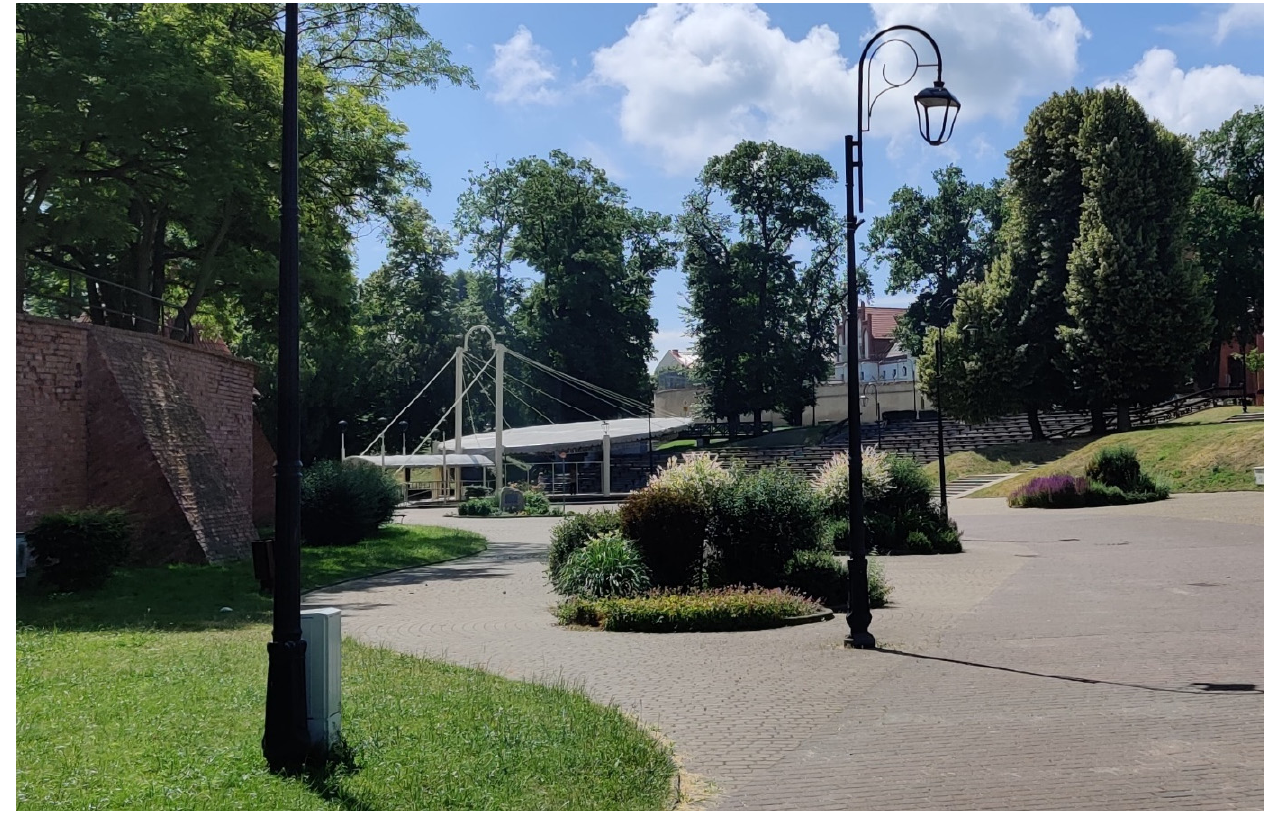
Figure 3. Amphitheater in Braniewo, Poland (Photo by Alicja K. Zawadzka, 27 June 2021). Table 7. The list of iconic building structures and sites with their assigned scores in Nowy Dwór Gda ń ski.